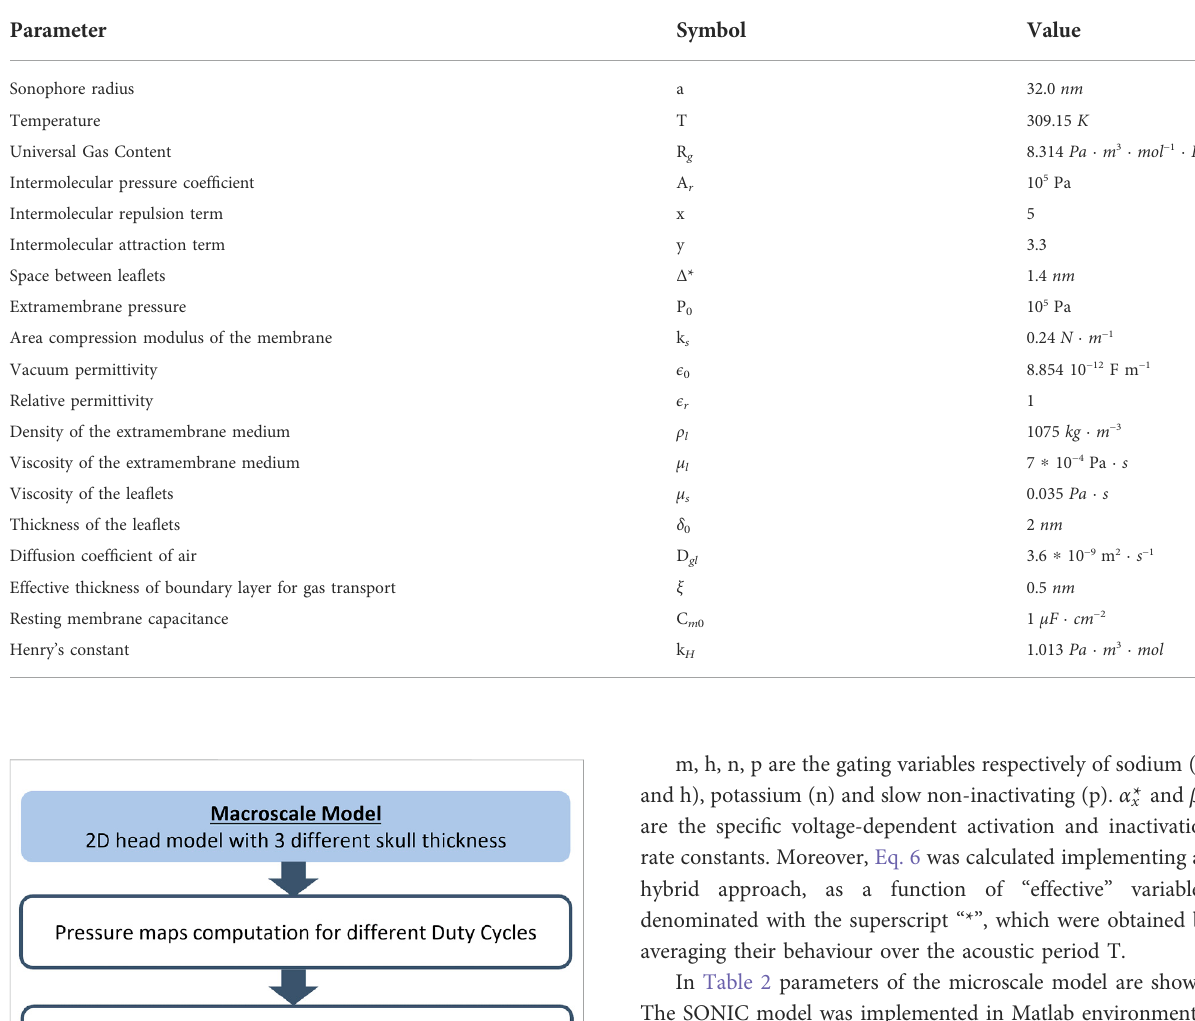
TABLE 2 Parameters of the model.